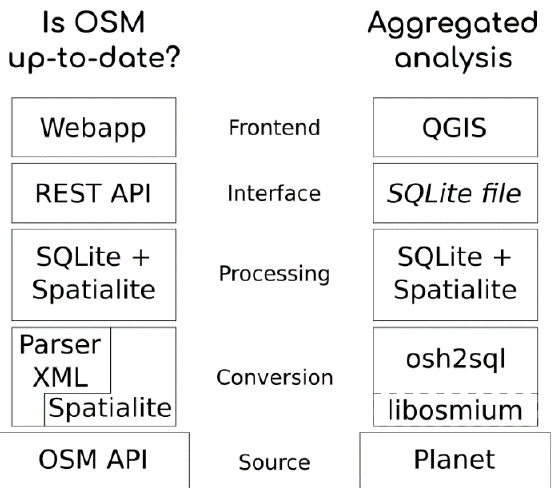
Figure 2. Open source software stacks for OSM intrinsic quality assessment: web application (left) and aggregated analysis (right).